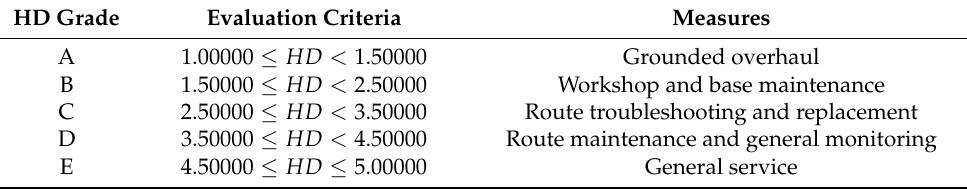
Table 12. HD grade and